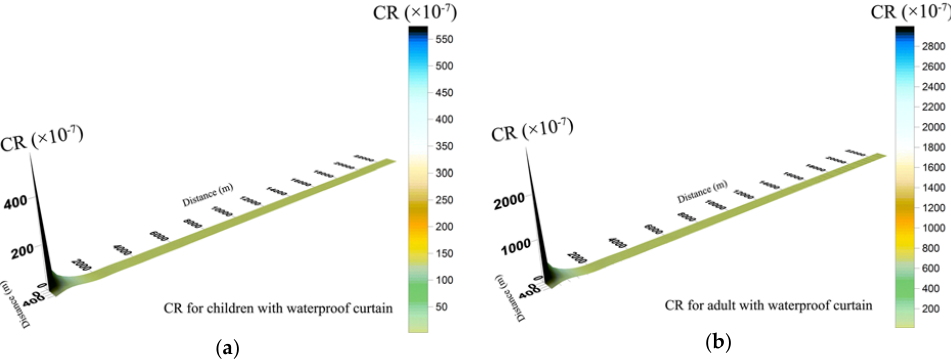
Figure 6. Spatial distribution of carcinogenic risk (CR) for children ( a ) and adults ( b ) during groundwater leakage with a waterproof curtain.